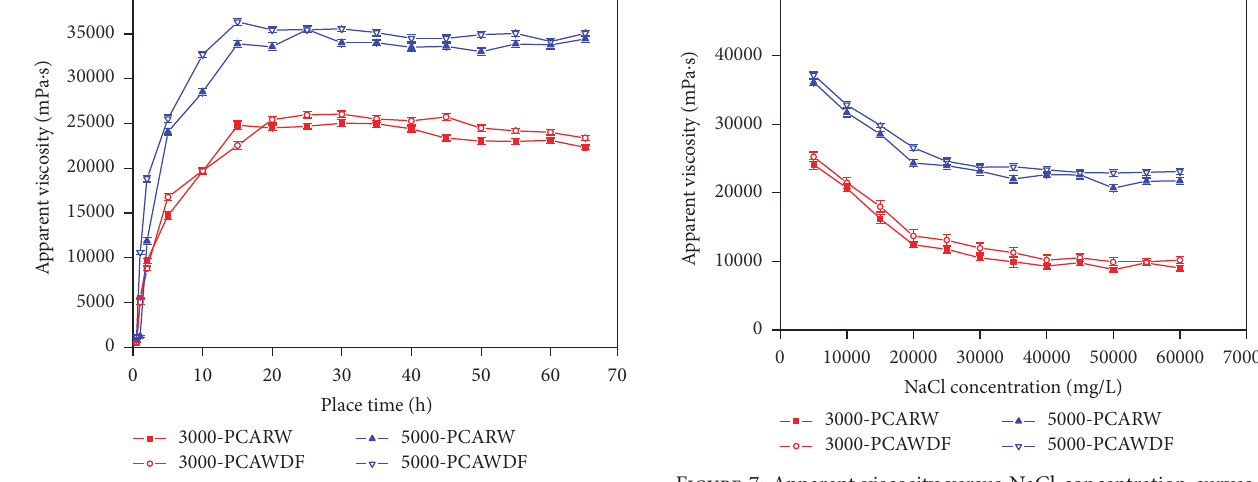
Figure 5: The apparent viscosity versus place time curves.